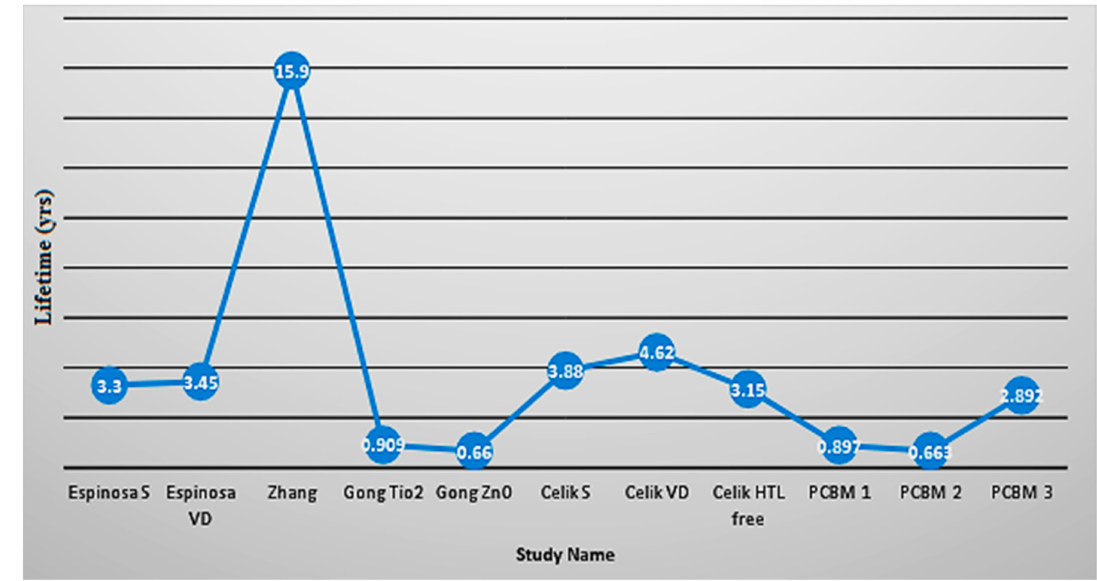
Figure 8. A look at the viability of commercial solar cells. Figure 7 provides a